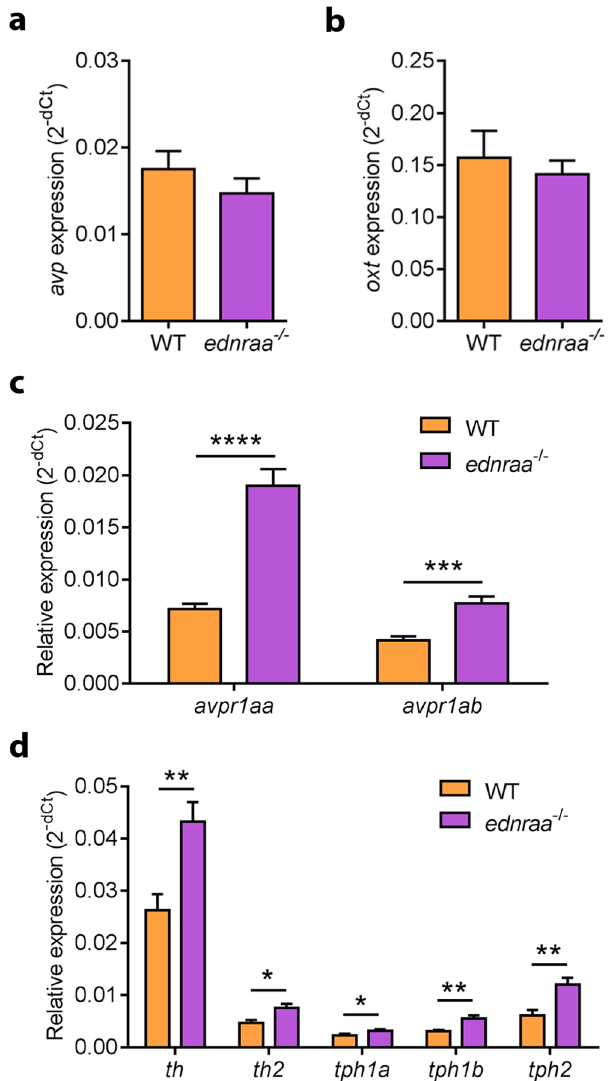
Figure 7. Expression of AVP and monoamine signalling pathway genes in ednraa − / − . qPCR data showing similar expression of (a) arginine vasopressin ( avp ) and (b) oxytocin ( oxt ) in ednraa − / − brains compared to WT. Increased expression of (c) arginine vasopressin receptor 1aa ( avpr1aa ) and arginine vasopressin receptor 1ab ( avpr1ab ) in ednraa − / − brains compared to WT. (d) Increased expression of tyrosine hydroxylase 1 ( th ), tyrosine hydroxylase 2 ( th2 ), tryptophan hydroxylase 1a ( tph1a ), tryptophan hydroxylase 1b ( tph1b ) and tryptophan hydroxylase 2 ( tph2 ) in ednraa − / − compared to WT. Multiple t-tests with Holm-Sidak multiple comparisons correction. * p < 0.05, ** p < 0.01, *** p < 0.001, **** p <